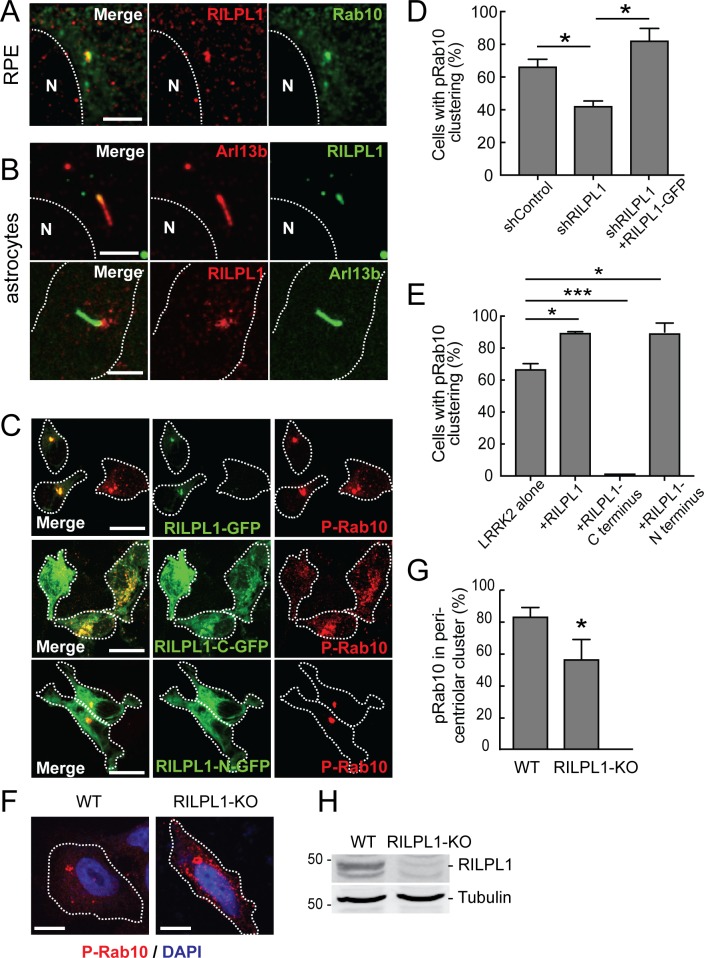
Localization of pRab10 is influenced by RILPL1.(A) RPE cells were ciliated for 24 hr and stained with rabbit anti-RILPL1 antibodies (red) and co-stained with mouse anti-Arl13b or rabbit anti-Rab10 antibodies (green). (B) Rat primary astrocytes were ciliated and stained with anti-RILPL1 and anti-Arl13B antibodies as indicated. (C–E) HEK293T cells were infected with lentiviral shRNA for RILPL1 and selected by puromycin. LRRK2-R1441G was co-transfected with either RILPL1-WT. Also, RILPL1-C-terminus GFP or RILPL1-N-terminus GFP (green) were co-transfected with LRRK2 in wildtype cells. After 24 hr, cells were stained with anti-phospho-Rab10 antibody (red). (D) Quantitation of cells with peri-centriolar clustering of pRab10 in RILPL1 knock down HEK293T cells, with or without rescue by (full length) RILPL1-WT. (E) Quantitation of peri-centriolar clustering of pRab10 in cells transfected with full length, RILPL1-N terminus, RILPL1-C terminus. (F) A549 WT and A549-RILPL1 knock out cells were transfected with myc-LRRK2-R1441G and 24 hr later, stained with anti-pRab10 (red) and DAPI (blue). (G) Quantitation of total pRab10 in peri-centriolar clusters. (H) A549 WT and A549-RILPL1 knock out cells were lysed and analyzed by immunoblotting with the indicated antibodies. Error bars represent SEM from three experiments with >50 cells per condition in each experiment. *, p<0.05; **, p<0.05; ***, p<0.001. Scale bar, 10 µm.